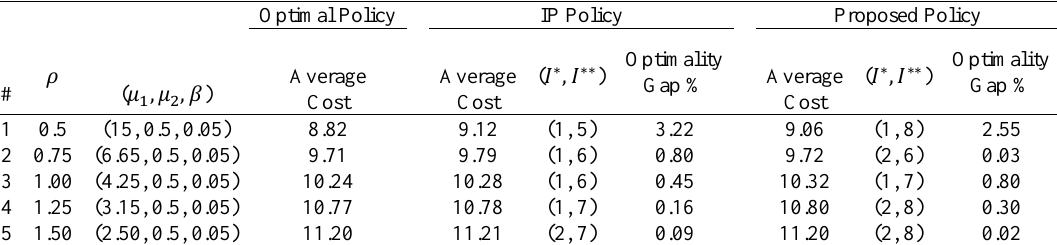
Table 7. Performances of the alternative policies with DFR distribution, s=2 and K=0.5